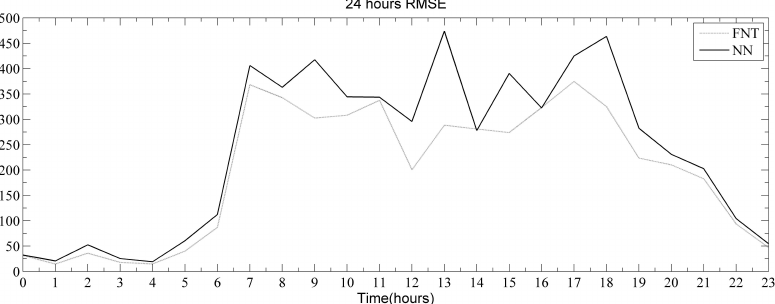
Figure 9. The 24 h RMSE values under FNT and NN in gate 2.